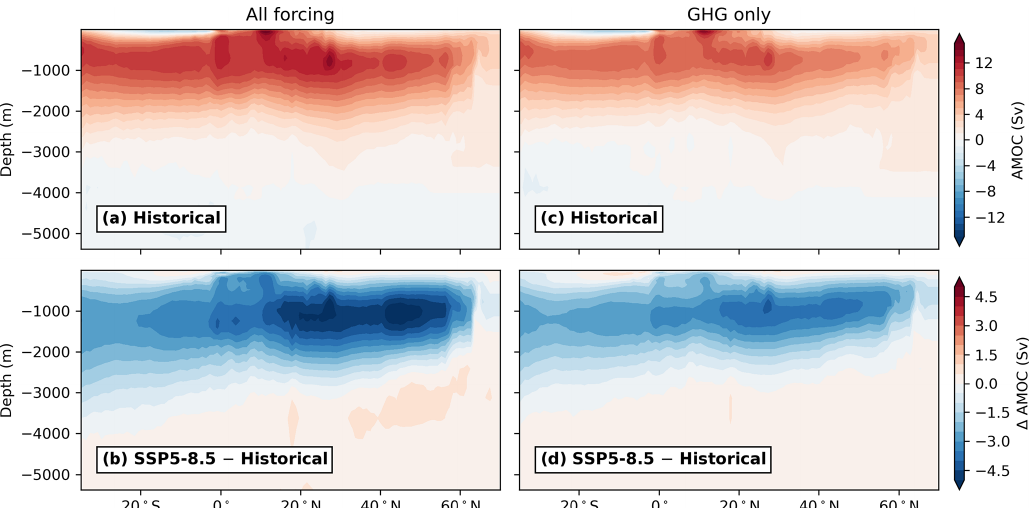
Figure 12. Ensemble averaged spatial patterns of (a, c) the mean and (b, d) changes of AMOC in (a, b) all-forcing simulations and (c, d) GHG-only simulations. The mean is averaged over the period of 1985–2014. The changes shows the difference between the period